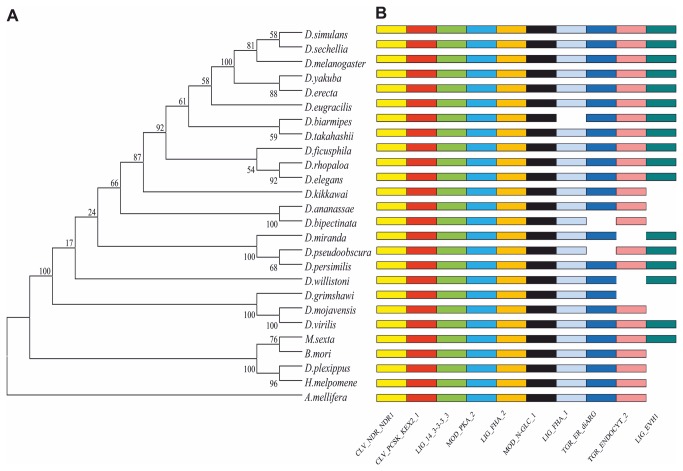
2MIT Phylogenetic analysis.(A) Unrooted phylogenetic tree of 2MIT protein in 21 Drosophilidae, 4 Lepidoptera and Apis mellifera. Statistical support for nodes on the trees was evaluated by the bootstrapping values (×500) shown in each branch point obtained by the Maximum-Likelihood method included in the MEGA 5.0 Software. (B) Colored bars at the right side of the phylogenetic tree represent binding motifs recognized by different factors in 2MIT ortholog cytoplasmic regions. CLV_NDR_NDR1: N-arginine dibasic convertase site; CLV_PCSK_KEX2_1: subtilisin-like proprotein convertases cleavage site; LIG_14-3-3_3: 14-3-3 ligand site; MOD_PKA_2: PKA Phosphorylation site; LIG_FHA_1 and LIG_FHA_2: FHA phosphopeptide ligands; MOD_N-GLC_1: N-glycosylation site; TRG_ER_diArg_1: di Arginine retention/retrieving signal; TRG_ENDOCYTIC_2: sorting signal motif; LIG_EVH1_1: EVH1 ligands.